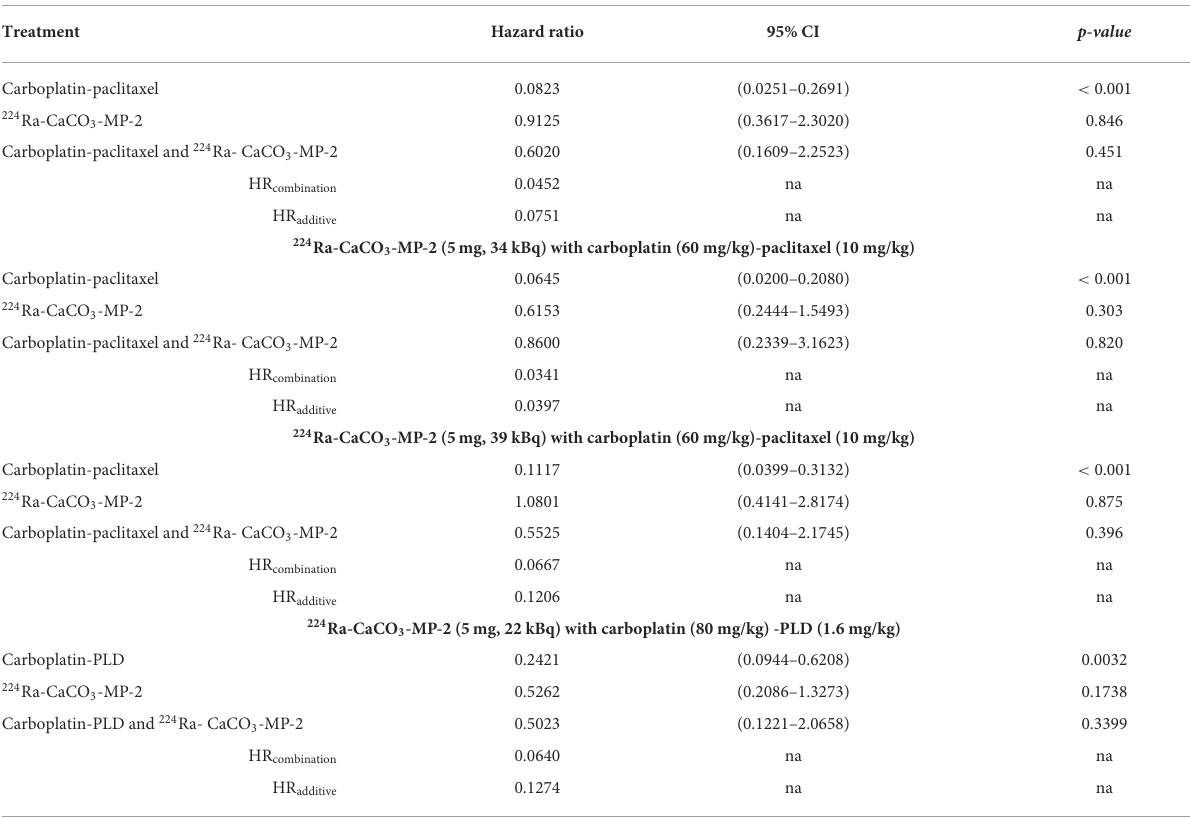
TABLE 2 Assessment of synergistic effect between 224 Ra-CaCO 3 -MP-2 and carboplatin-paclitaxel or